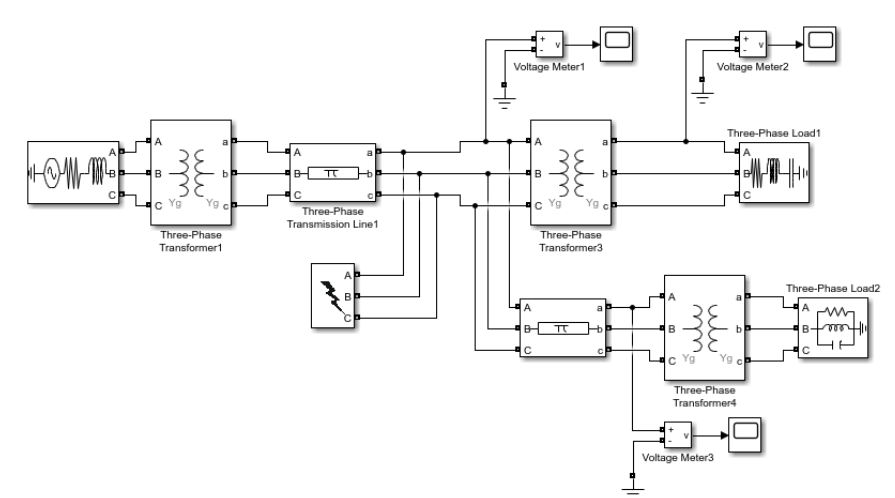
Figure 1. Simulink system for generating voltage sag disturbance induced by line fault.